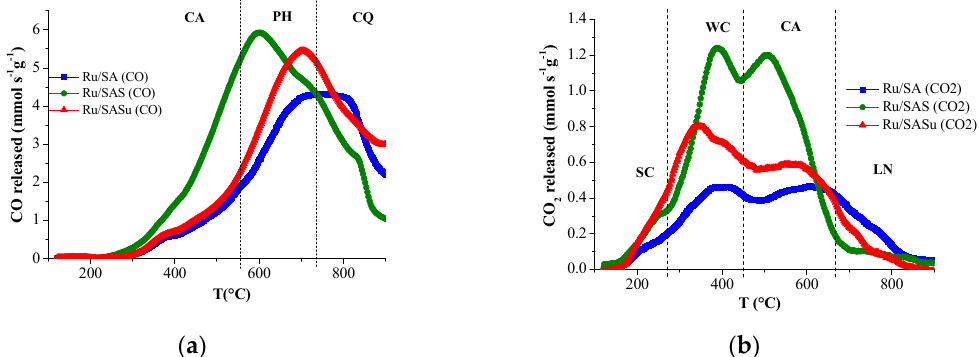
Figure 1. CO (a) and CO 2 (b) TPD profiles for the Ru containing samples (SC: strong carboxylic acid, WA: weak carboxylic acid, CA: carboxylic anhydride acid, PH: phenol, CQ: Carbonyl and Quinone, LC: Lactone).